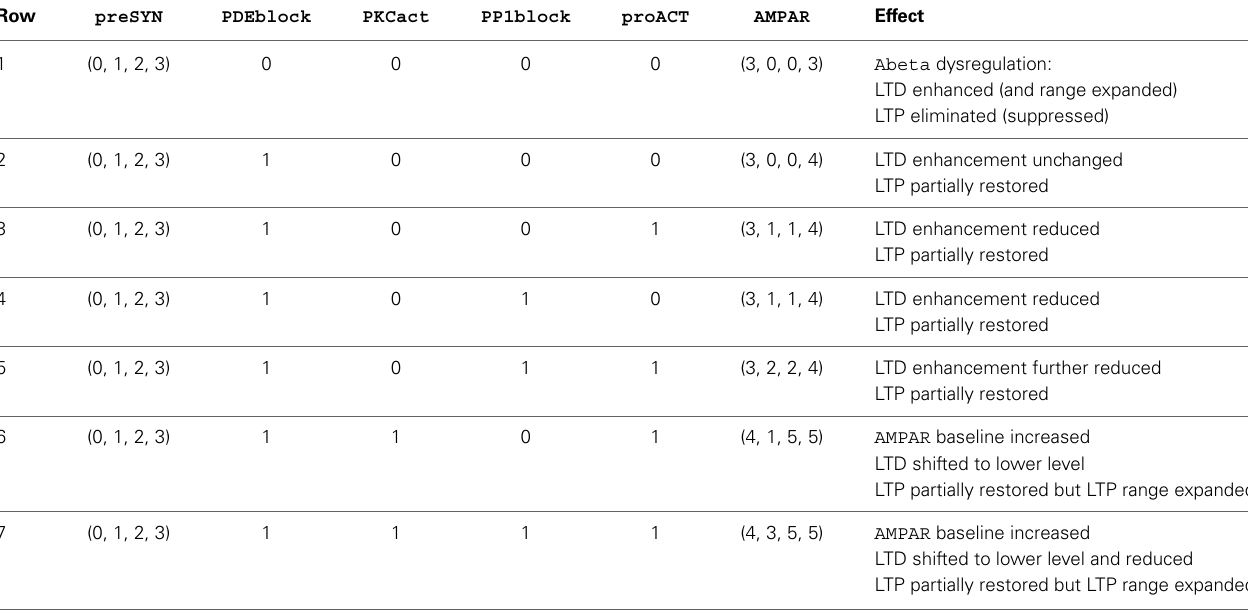
Table 5 | Effects on synaptic plasticity of compounds that modify signaling